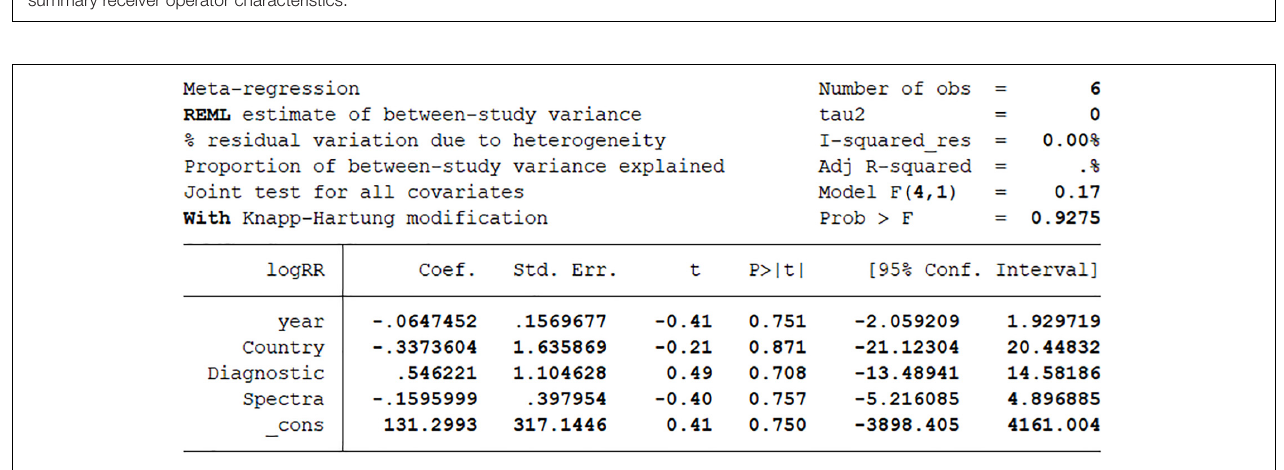
FIGURE 6 | Meta-regression analysis on year, country, diagnostic algorithm,